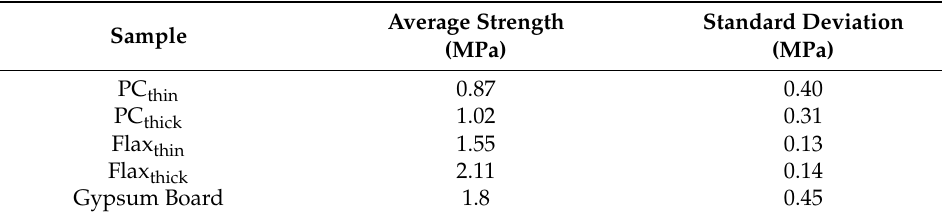
Table 3. Honeycomb-sandwich-panel ultimate strength.